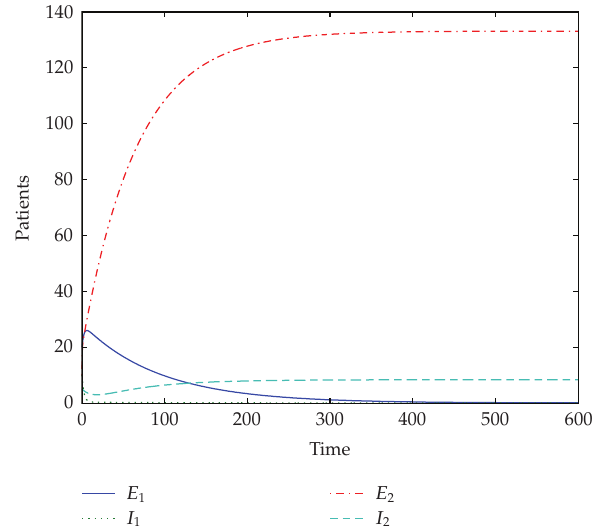
Figure 6: Trajectories of system (cid:2) 2.2 (cid:3) when β 1 (cid:2) N (cid:3) (cid:8) β 1 , β 2 (cid:2) N (cid:3) (cid:8) β 2 , β 1 (cid:8) 0 . 001, β 2 (cid:8) 1, d 1 (cid:8) 0 . 02, d 2 (cid:8) 0 . 07, so that R 1 < 1, R 2 > 1. It shows that the boundary equilibrium P 1 is